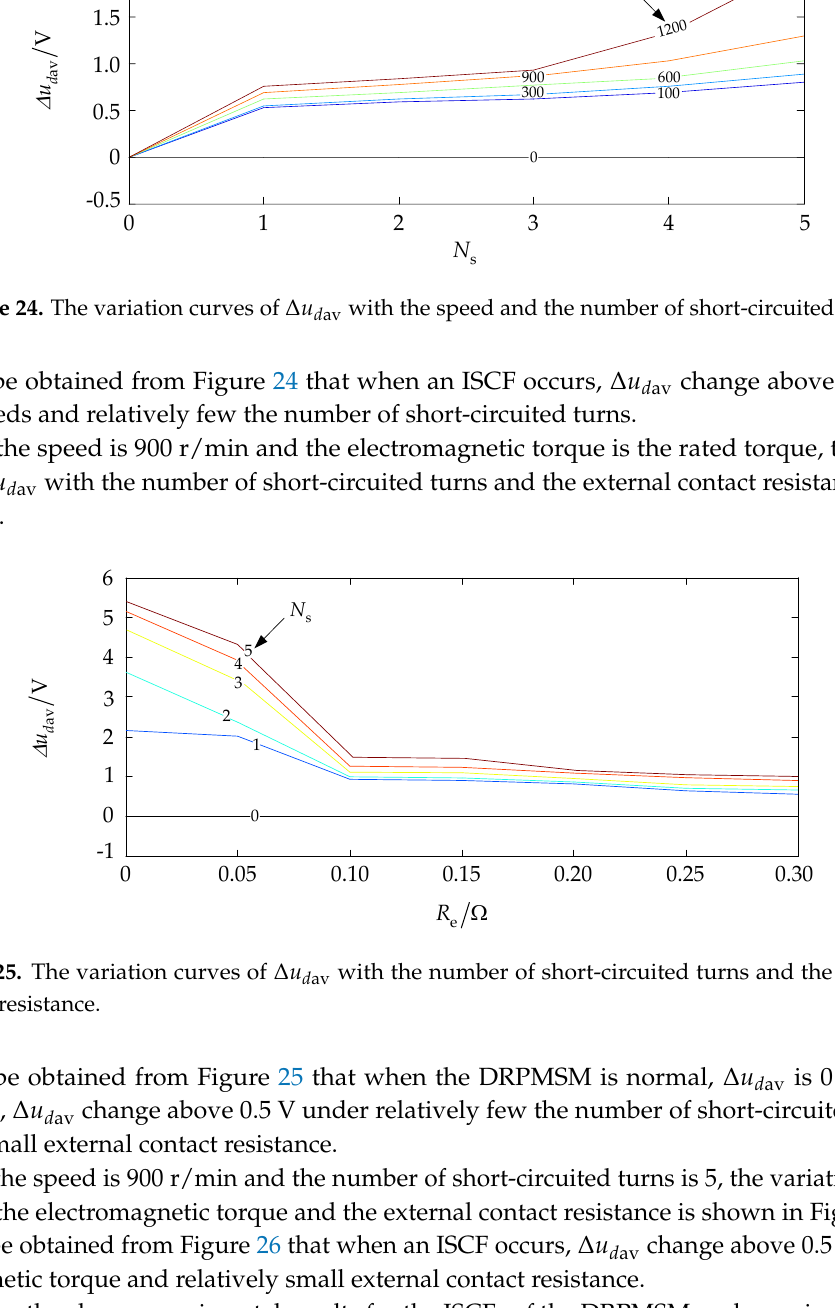
Δ u change above 0.5 V under av d change above 0.5 V under